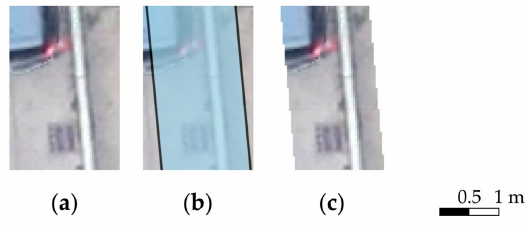
Figure 2. ( a ) A small part of an unclipped orthoimage. The object in the upper left is part of a car and the object in the lower middle is a sewer inlet; ( b ) the clipping mask overlaid on the orthoimage; ( c ) the clipped